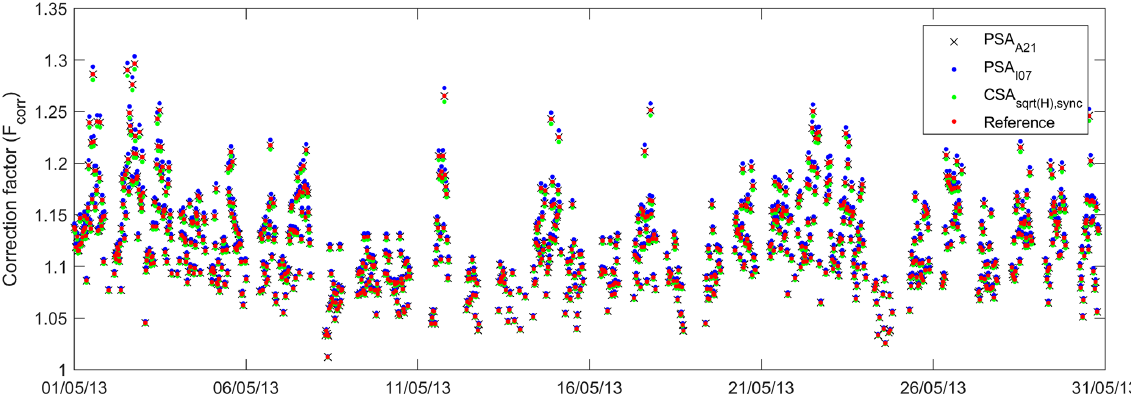
Figure 10. Correction factors ( F corr ) of half-hourly fluxes calculated with different approaches, i.e. PSA A21 (black cross), PSA I07 (blue point), CSA √ (green point), and the reference (red point) for the case with τ = 0 . 3s and SNR of H, sync